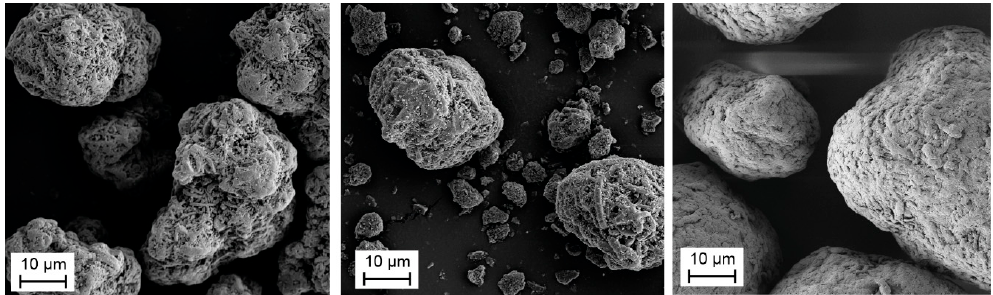
Figure 3. SEM images of the flame retardant fillers Exolit 1230 ( left ) and Exolit 1400 ( middle ) and the PA12 powder ( right ) with a magnification factor of 1000×.